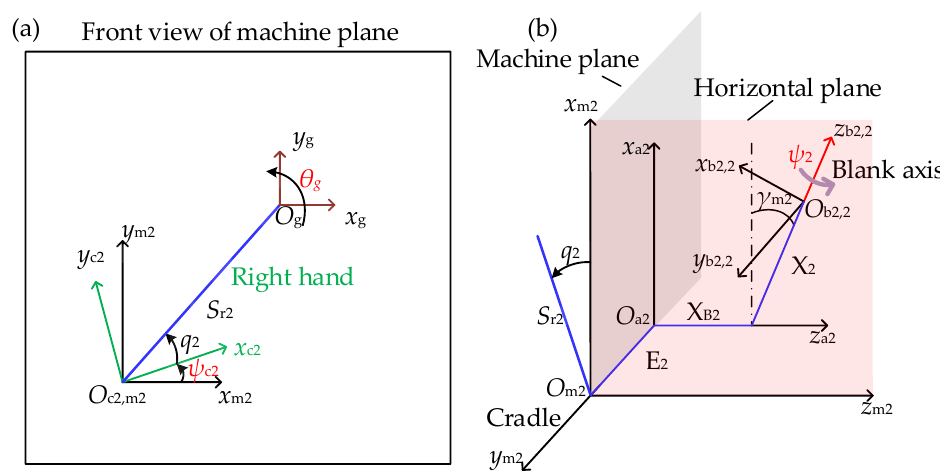
Figure A1. The layout of the machine tool coordinate for machining bevel gear by the generating method: ( a ) Front view; ( b ) General view. The machine tool coordinate for machining bevel pinion by the tilt method is illustrated in Figure A2; any point of the cutter in the cutter coordinate system O p - x p - y p - z p can be expressed in the blank coordinate system through the following coordinate transformation: